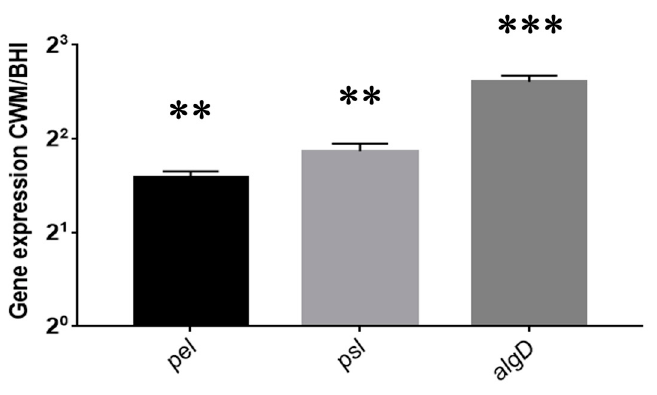
Figure 4. Expression of Pseudomonas aeruginosa PAO1 pel , psl and algD genes after recovering sessile cells in the BioFlux TM system after 72 h of culture. The normalized relative expressions of the studied genes in the CWM were determined for each strain according to the equation 2 − ∆∆ Ct, where ∆∆ Ct = (Ct gene − C rpoD ) in the CWM-(Ct gene − Ct rpoD ) in the BHI medium. Results are presented as the mean ± standard deviation of three different experiments. Statistics were performed using a t -test on GraphPad Prism version 7. ** p < 0.01; *** p <